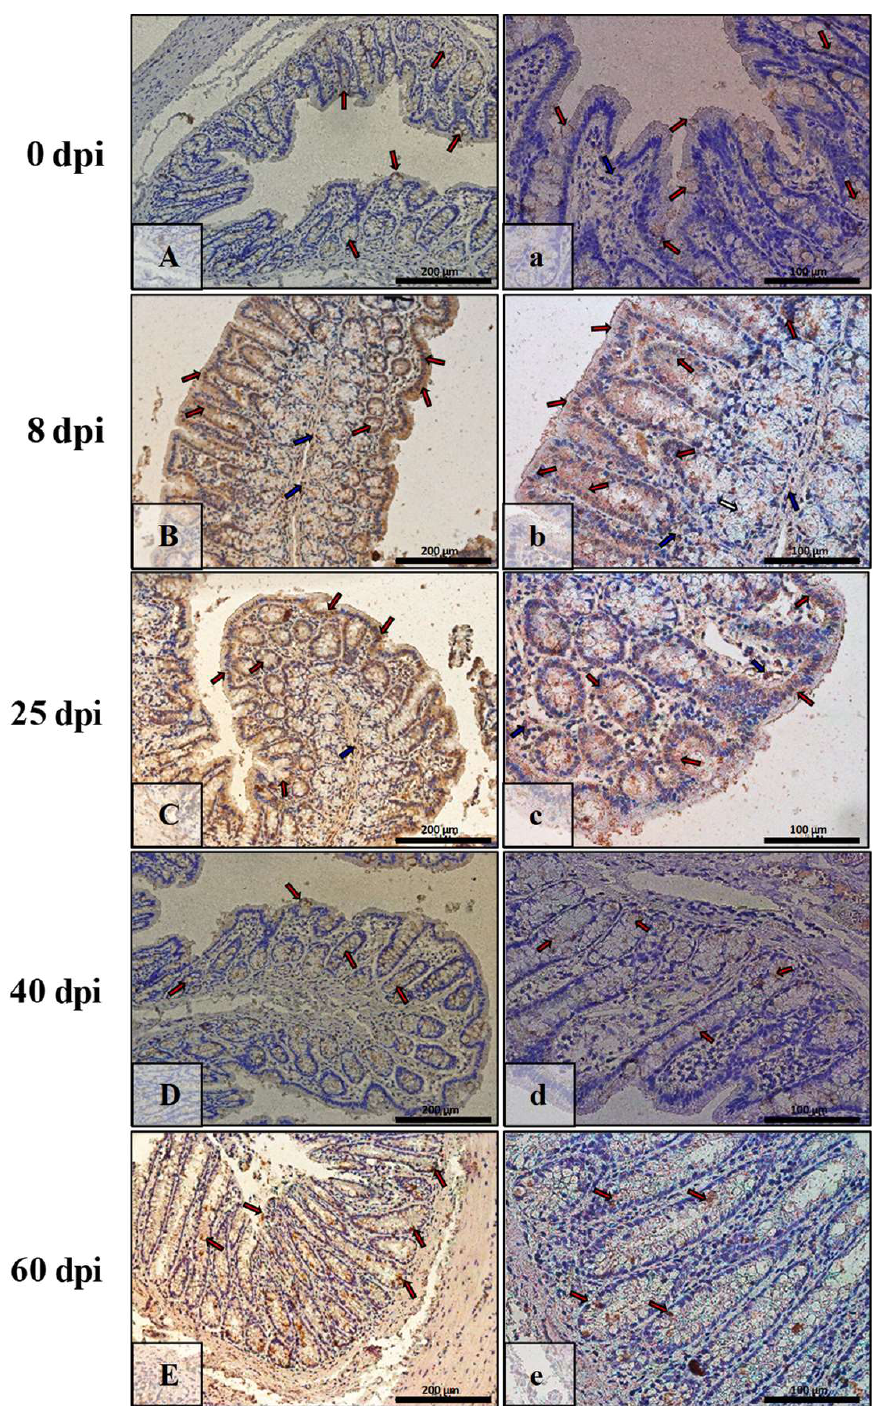
Figure 8. Representative microphotographs showing Bax immunoexpression in the colon of control animals ( A , a ) and on consecutive days ( B , b , C , c , D , d , E , e ) after H. diminuta infection. Positive IHC reaction—brown reaction indicated by arrows: red—epithelial cells of the intestinal villi and crypts, blue and white—cells in the connective tissue lining of the mucosa. Lens magnification: ×20 ( A – E , scale bar: 200 μm), ×40 ( a – e , scale bar: 100 μm).